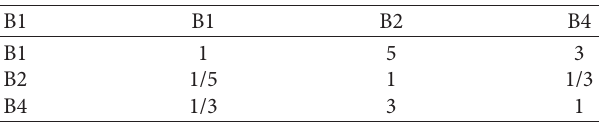
Table 4: The judgment matrix of major criteria with respect to business level (B1).